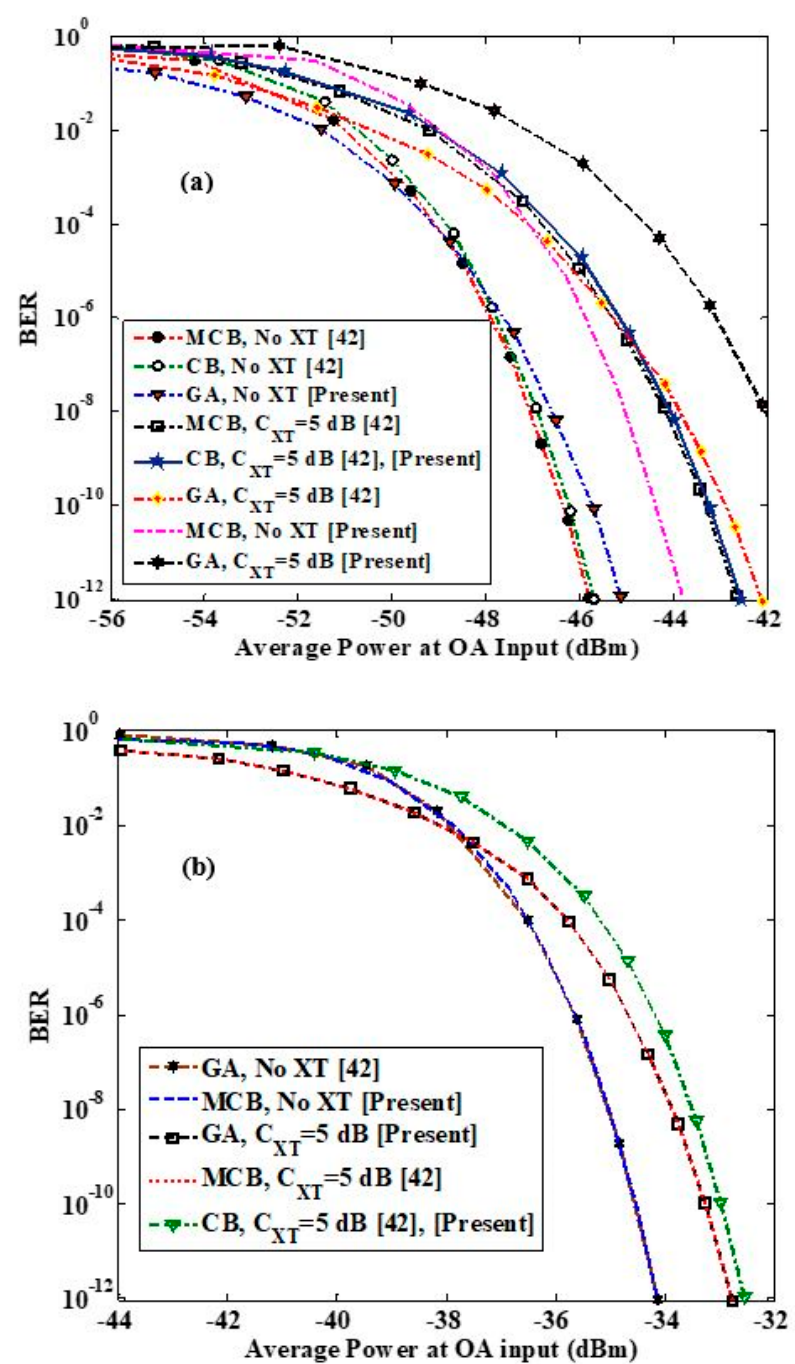
Figure 3. BER against average optical power (AOP) (dBm) using for ( a ) G = 27 dB [42] at 1500 m and G = 30 dB [present work] at 4000 m and ( b ) G = 8 dB ST is demonstrated in [42] at 1500 m and [present work] at 4000 m.